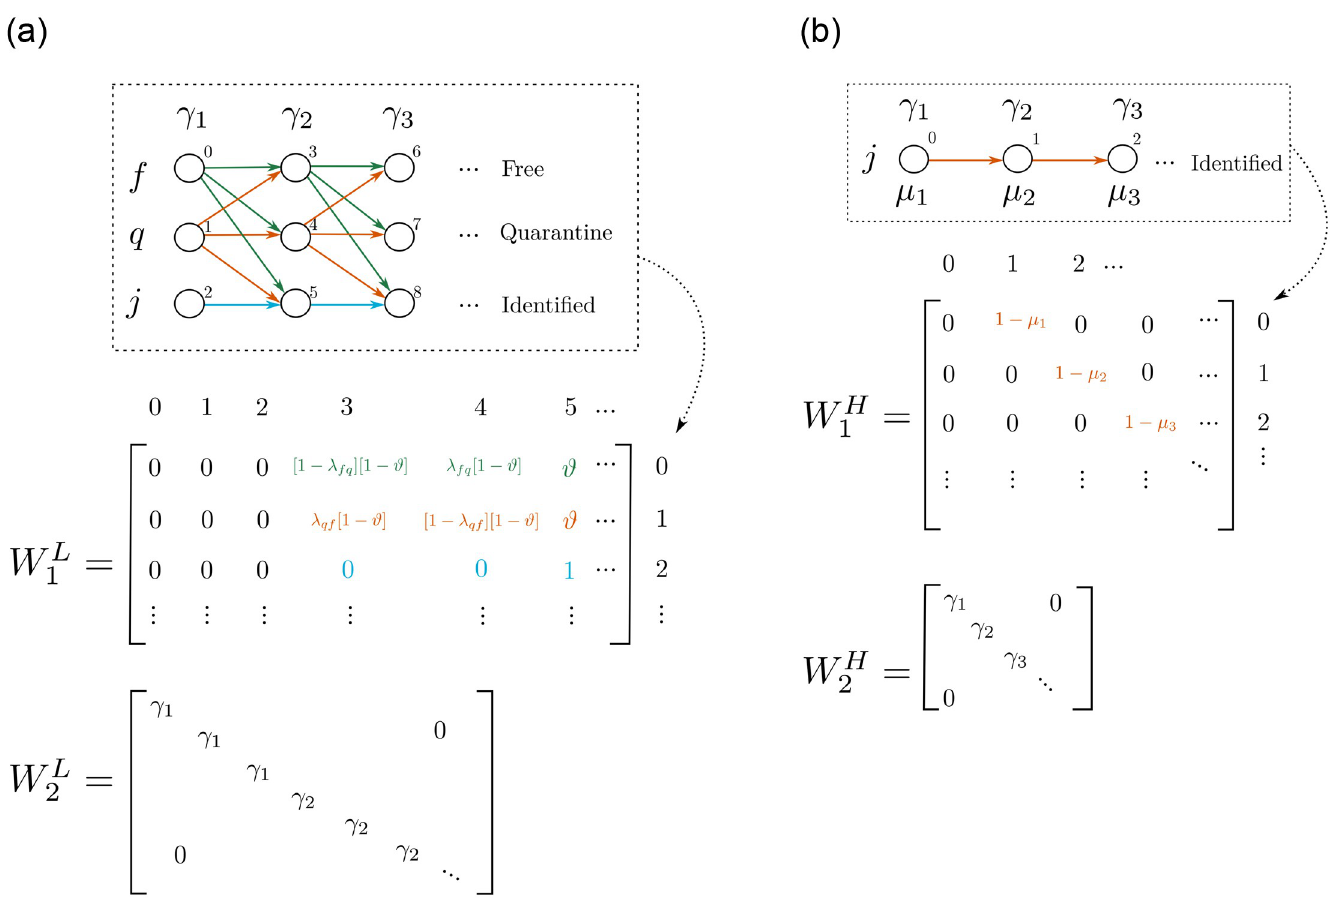
Fig 3. Example of diffusion matrices for L and H deduced from an order for the nodes (enumeration). Note that individuals in L have f Ð q | j flow (matrix W L recover flow (matrix W L ). λ qf and λ fq are the probabilities of incoming or leaving quarantine, respectively; ϑ is the probability of being identified as infected. Individuals 2 ) or die (matrix W H ). Values for γ i and μ i are obtained as shown in Fig 2. For the mathematical description of the matrix, see sections 3.2.4 in H can recover (matrix W H 2 1 and 3.2.5. (a) Diffusion process for L , (b) Diffusion process for H